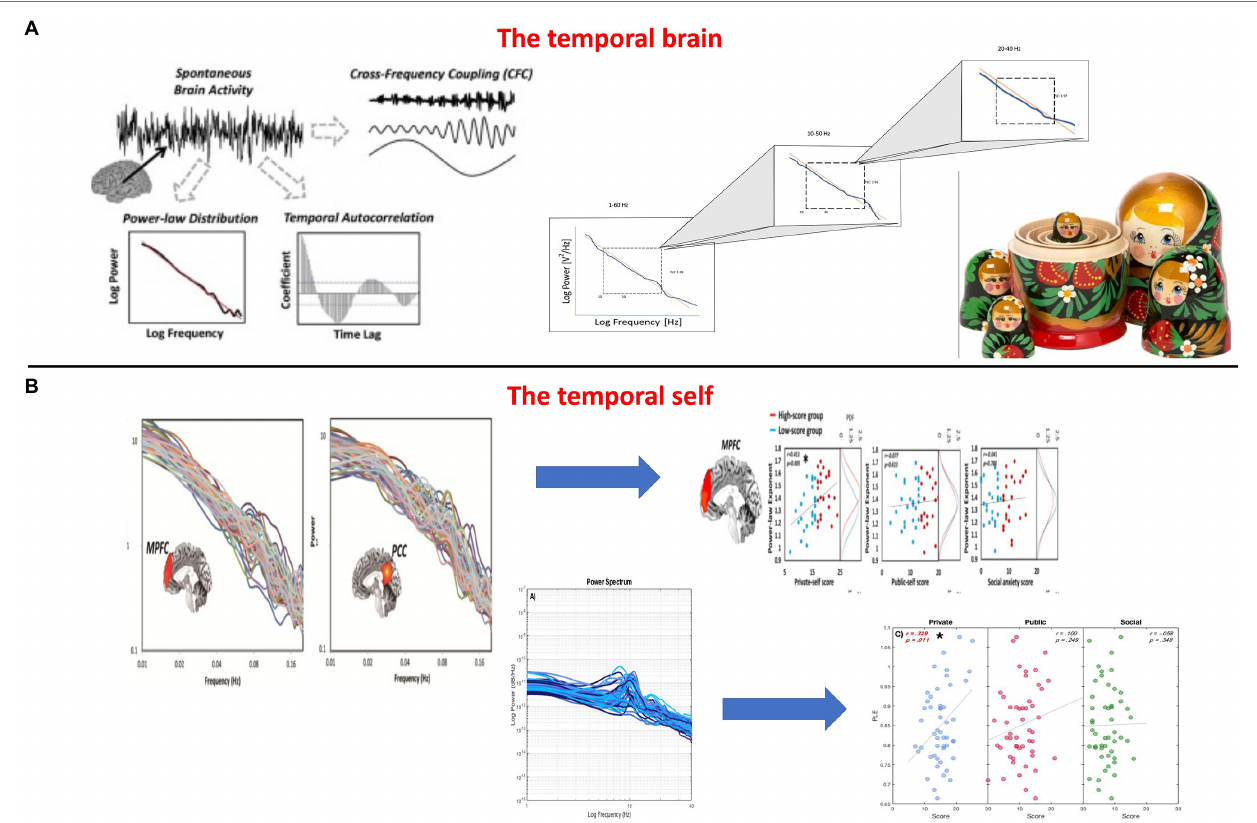
FIGURE 6 | (A) The temporal brain – Temporal nestedness with scale-free activity in the brain (left and upper right) just like Russian dolls with their spatial nestedness (lower part). (B) The temporal self – From the brain’s scale-free activity with its temporal nestedness to the self in infraslow frequencies of fMRI (upper right/Huang et al., 2016) and faster frequencies of EEG (lower right, Wolff et al.,